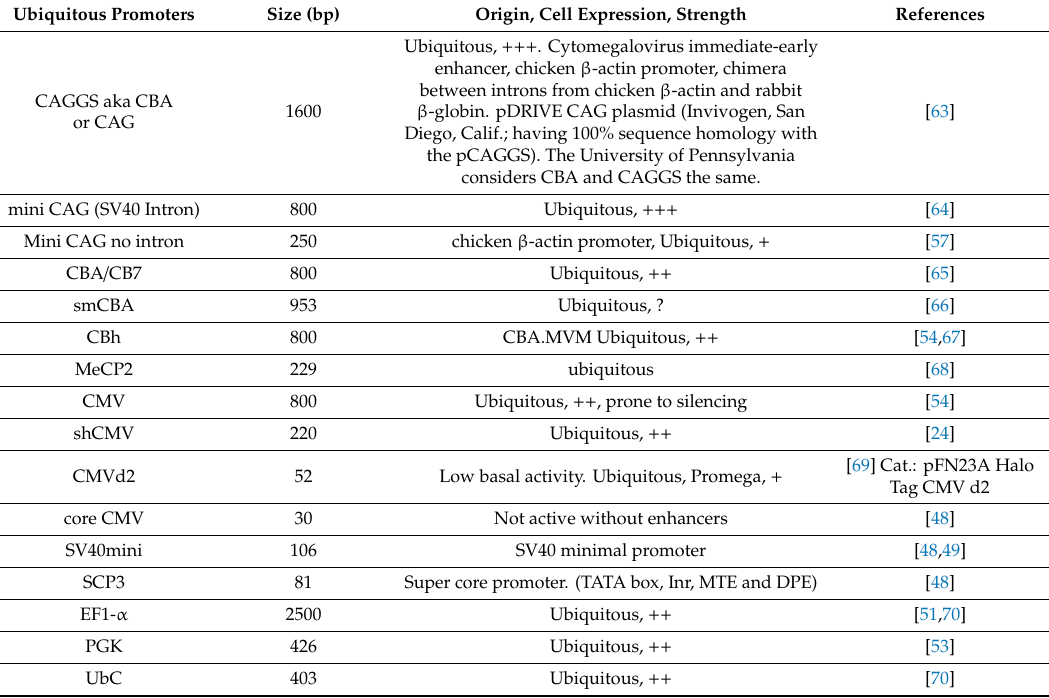
Table 2. Common ubiquitous promoters for rAAV-based ocular gene